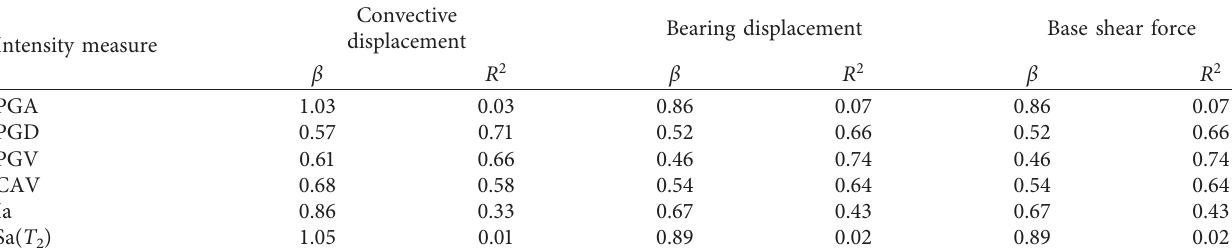
Table 3: Linear regression analysis results.